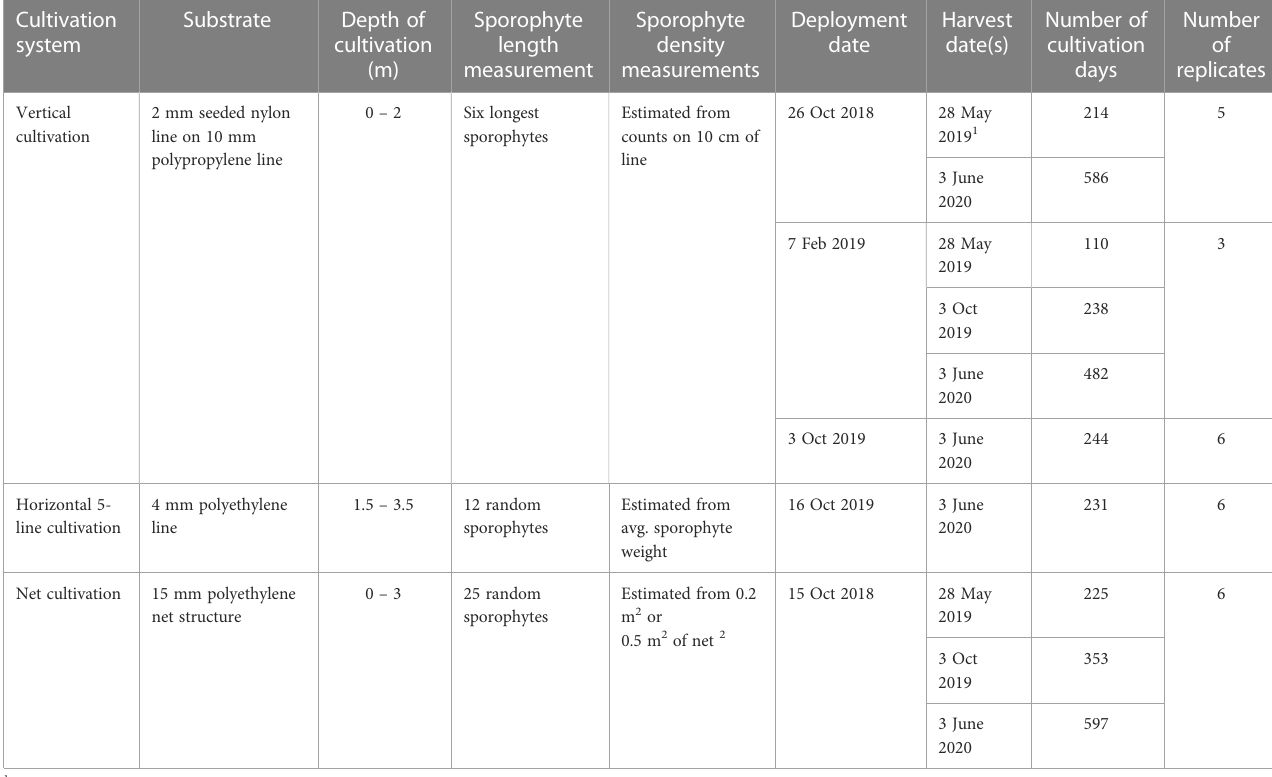
TABLE 1 Overview of the cultivation systems and monitoring methods used during this study. Cultivation